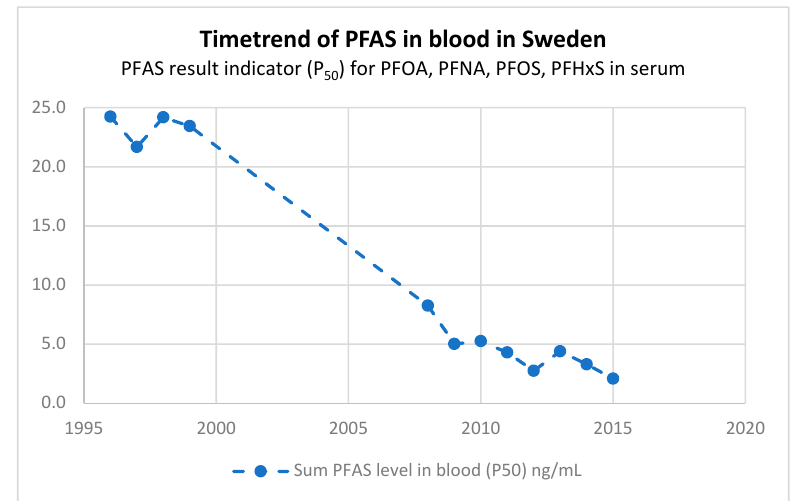
Figure 5. Time trend result indicator of PFOS, PFOA, perfluorononanoic acid (PFNA), and perfluorohexane sulfonate (PFHxS) for the Swedish population (men, women, and children, P 50 ). The per- and polyfluoroalkyl substance (PFAS) levels in blood, P 50 (ng/mL), of PFOA, PFNA, PFOS, and PFHxS were for each year, first summed for each of the age groups, and then averaged over the age groups, resulting in a group substance population indicator. The time trend shows a steady decrease since 1996 for the total PFAS HBM exposure levels, mainly driven by a decrease in PFOS levels. Note: older people were not included for the years 2012–2015.